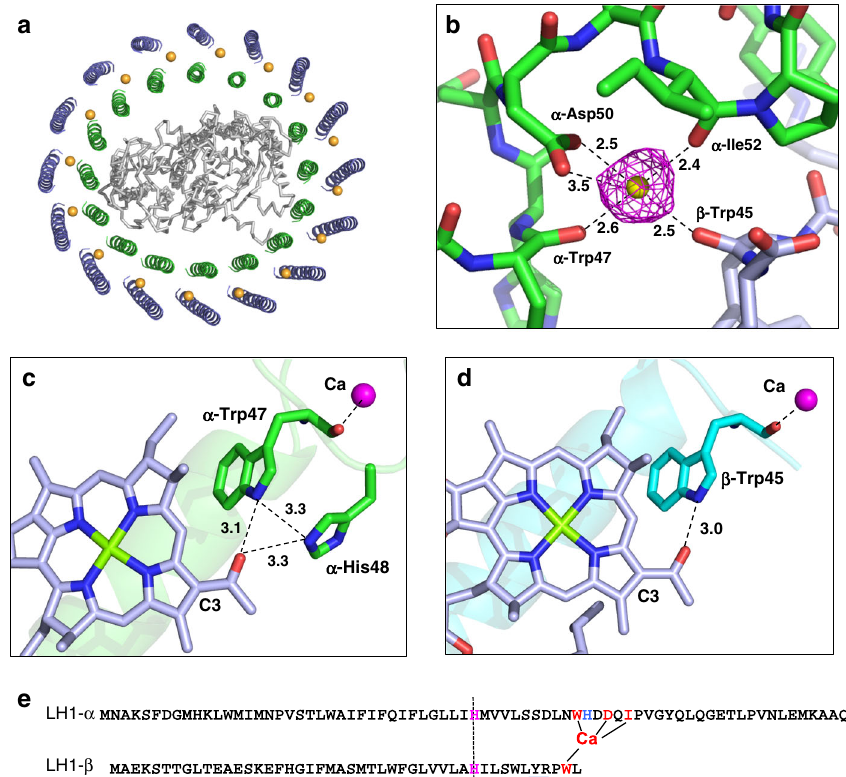
Fig. 2 Ca 2 + - and BChl a -binding sites in the Trv . strain 970 LH1 complex. a Top view of the LH1-RC from the periplasmic side of the membrane. Color scheme: LH1 α , green; LH1 β , slate blue; L- and M-subunits, gray; Ca 2 + , orange balls. b A typical Ca 2 + -binding site in LH1. Color scheme: LH1 α , green; LH1 β , light-blue; Ca 2 + , yellow ball. Density map is shown in magenta mesh around the Ca 2 + at a contour level of 2.5 σ . c Hydrogen bonding site around BChl a C3-acetyl group (light-blue sticks) in LH1 α -polypeptide (green). The Ca 2 + (magenta ball) is ligated by the main chain oxygen atom of α -Trp47. d Hydrogen bonding site around BChl a C3-acetyl group (light-blue sticks) in LH1 β -polypeptide (cyan). The Ca 2 + (magenta ball) is ligated by the main chain oxygen atom of β -Trp45. e Sequence scheme showing the relative positions of the Ca 2 + - and BChl a -binding sites. The LH1 αβ -polypeptides are aligned relative to the BChl a -coordinating histidine residues (magenta letters with vertical dashed line). Underlined region represents presumed membrane- spanning domain. All distances are in